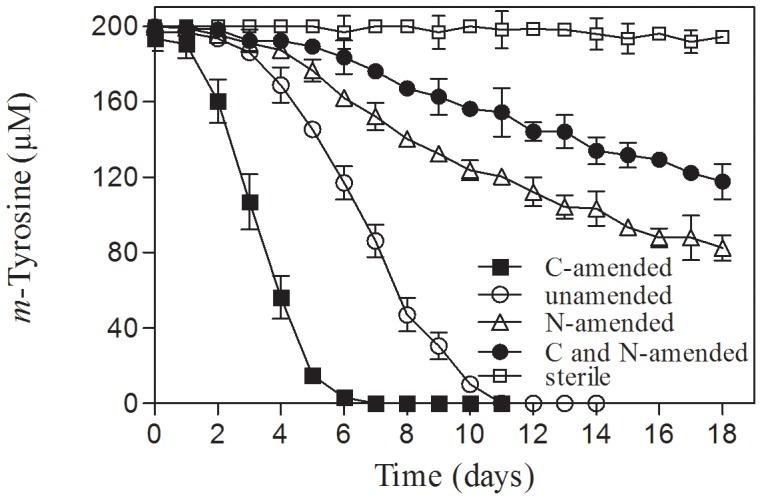
Biotransformation of m-tyrosine in soil microcosms under aerobic conditions.(▪), carbon-amended; (○), unamended; (Δ), nitrogen-amended; (•), carbon and nitrogen-amended; (□), sterile. Values are presented as arithmetic mean of data obtained from experiments carried out in triplicate; error bars represent standard deviation.